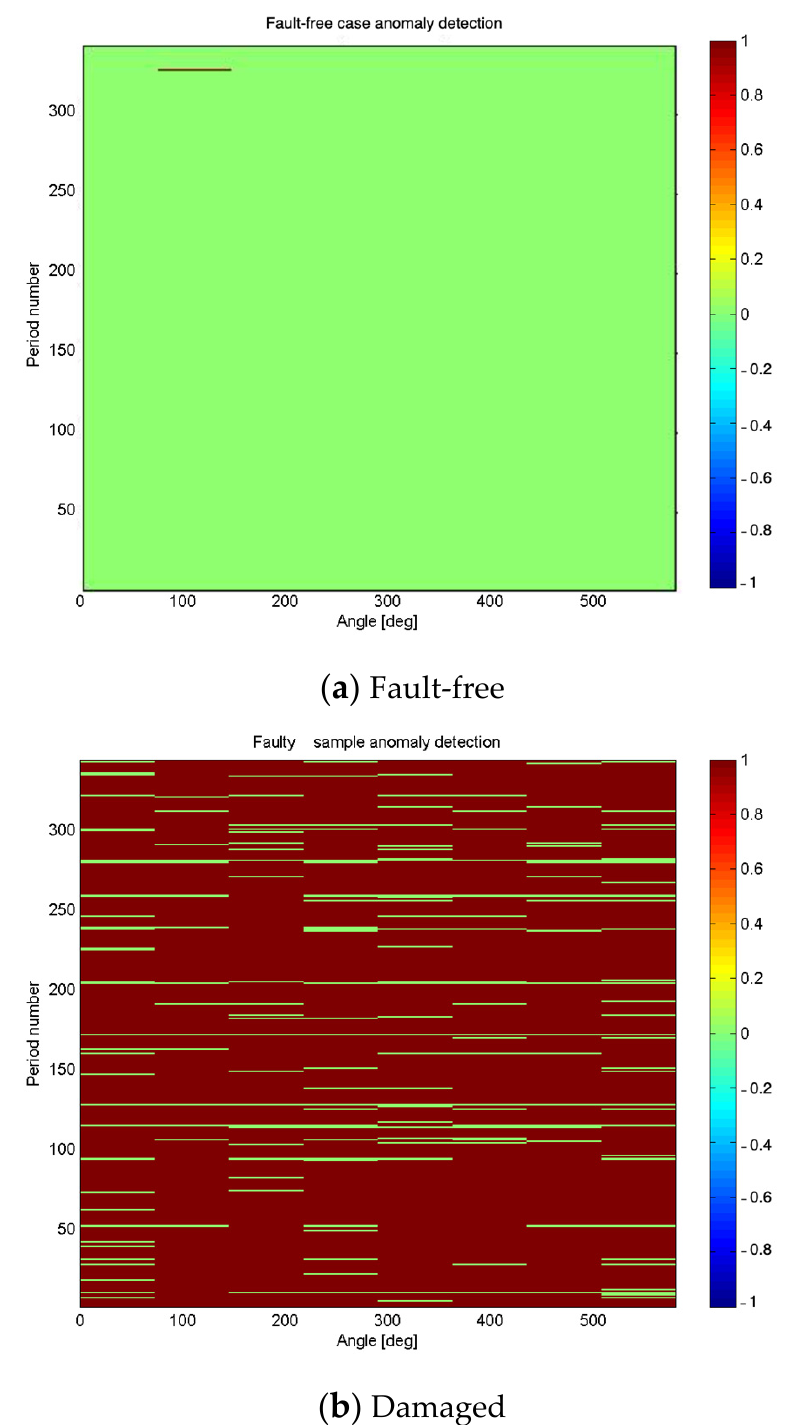
Figure 9. The anomaly detection decision maps, obtained using k-means and k-NN approaches for bearing bearing signal.